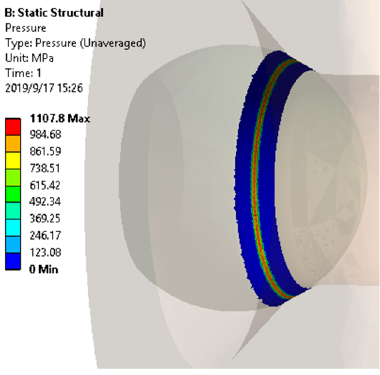
Figure 10. The simulation results of contact stress.